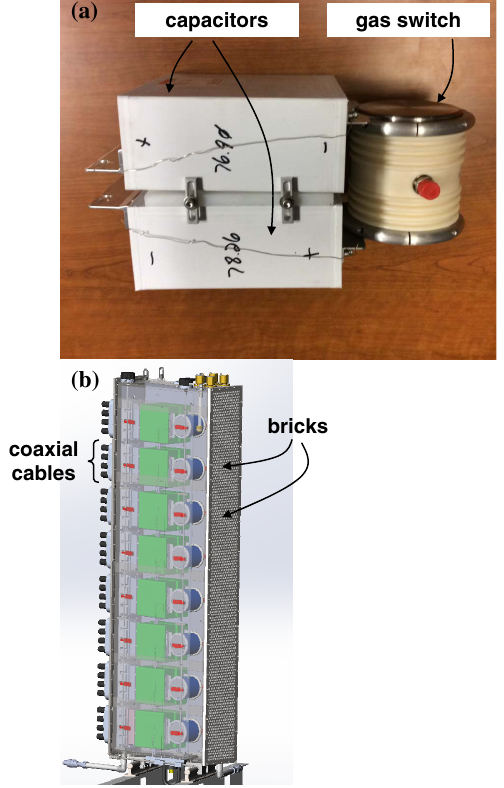
FIG. 2. (a) Individual brick consisting of two capacitors connected to a gas switch. (b) Brick tower consisting of 8 bricks, stacked vertically each with up to 4 cable